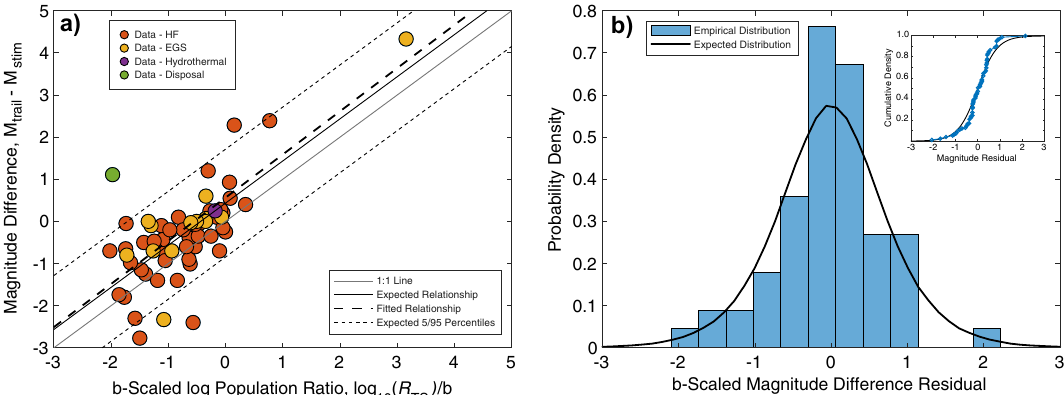
Figure 3. Testing Båth’s law for induced seismicity. ( a ) Linear regression of magnitude differences ΔM versus logarithmic population ratios 1 b log 10 ( R TS ) : data is separated by anthropogenic type (circles) and shown alongside the 1:1 line (solid gray line), the relationship expected by Båth’s law (solid black line), the regression fit to data (dashed line), and the corresponding 5/95 percentiles (dotted line). ( b ) The residuals to the expected Båth’s law relationship are shown as probability density function for the expected (solid black line) and empirically derived from data (blue bars). Inset panel shows the cumulative density function for the expected (solid black line) and empirically derived residuals (blue